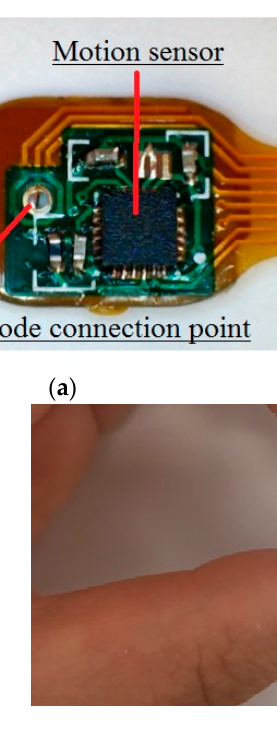
Figure 11. The flexible printed circuit.